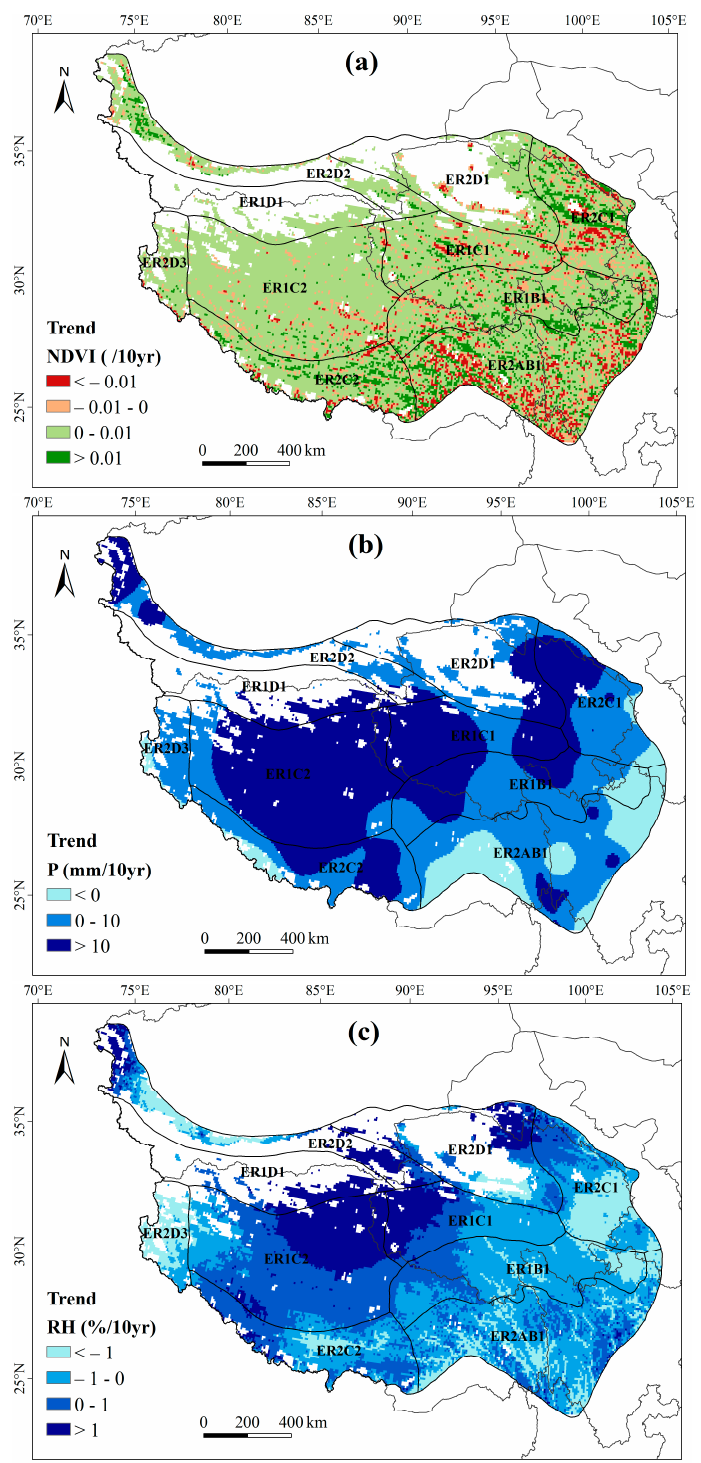
Figure 2. The spatial distributions of NDVI ( a ), precipitation ( b ), and relative humidity ( c ) trends during the 1982–2015 period. The blank regions represent non-vegetation area defined in this study (annual average NDVI<0.1). The same